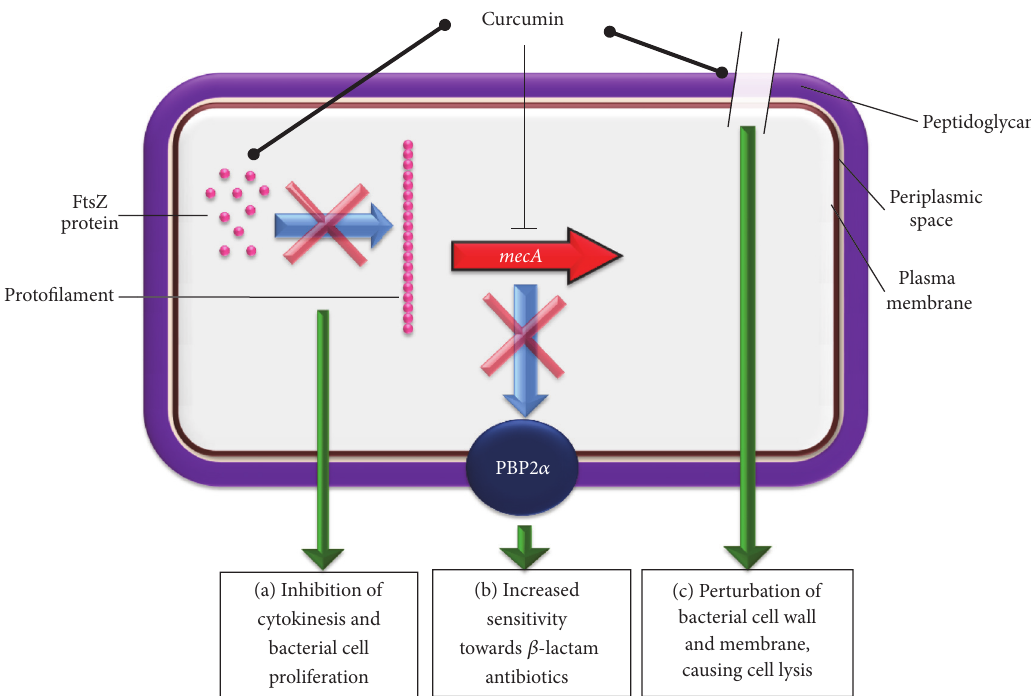
Figure 2: The potential mechanisms underlying the antibacterial effect of curcumin against S. aureus . Circle-shaped arrow indicates binding whereas blocked arrow represents inhibition. (a) Curcumin may bind into FtsZ proteins, thereby inhibiting the assembly of FtsZ protofilaments. This, in turn, suppresses the formation of Z-ring leading to inhibition of cytokinesis and bacterial proliferation [44]. (b) In the case of MRSA, curcumin could inhibit the mecA gene transcription, causing reduced expression of PBP2 𝛼 proteins. As a result, MRSA can be sensitized towards the antibacterial action of 𝛽 -lactam antibiotics such as Penicillin and Methicillin [32]. (c) The binding between curcumin and peptidoglycan on S. aureus cell wall could trigger damage on the cell wall and membrane, leading to cell lysis of S. aureus [30, 32].